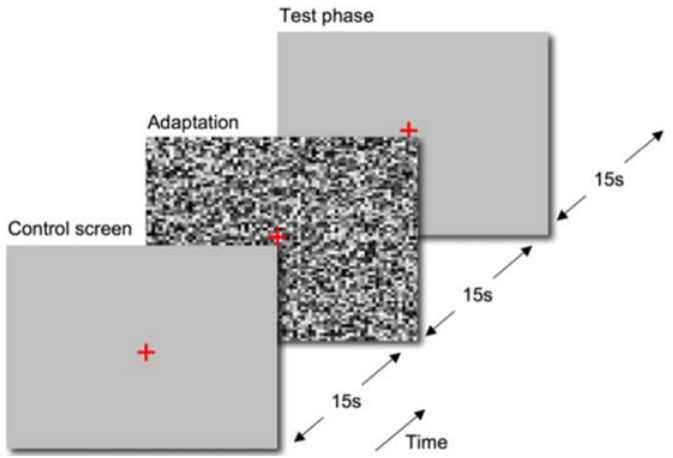
Figure 1. Stimulus presentation. The control screen was an isoluminant grey screen presented for 15 seconds to determine whether subjects could trace their scotoma boundary against a regular background. The adaptation phase was a dynamic field of random greyscale noise presented at 60Hz for 15 seconds. The test phase was a further isoluminant grey screen presented for 15 seconds. Subjects were asked to mark the boundary of any illusory area by means of a touchscreen mounted to the monitor. A red cross of arm length 1 u was present throughout to guide fixation for the drawing phase. Adaptation and test phase were repeated to a total of five times. observers. The white lines show the boundary of scotomas defined by microperimetry. The red lines show the geometric mean of the apparent perimeter of the TwAE mapped by the observers. The shaded grey areas indicate 95% confidence intervals on this mean, based on a minimum of five repetitions. There was excellent agreement between both measures of the scotoma.